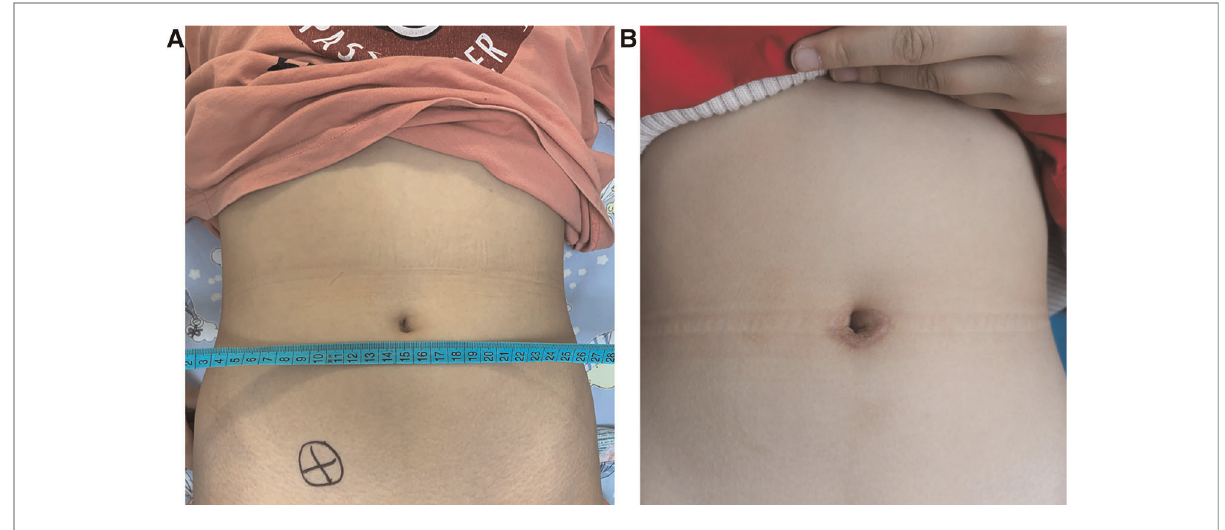
FIGURE 5 Appearance of umbilicus: ( A ) the appearance of preoperative umbilicus and ( B ) the appearance of postoperative umbilicus after one